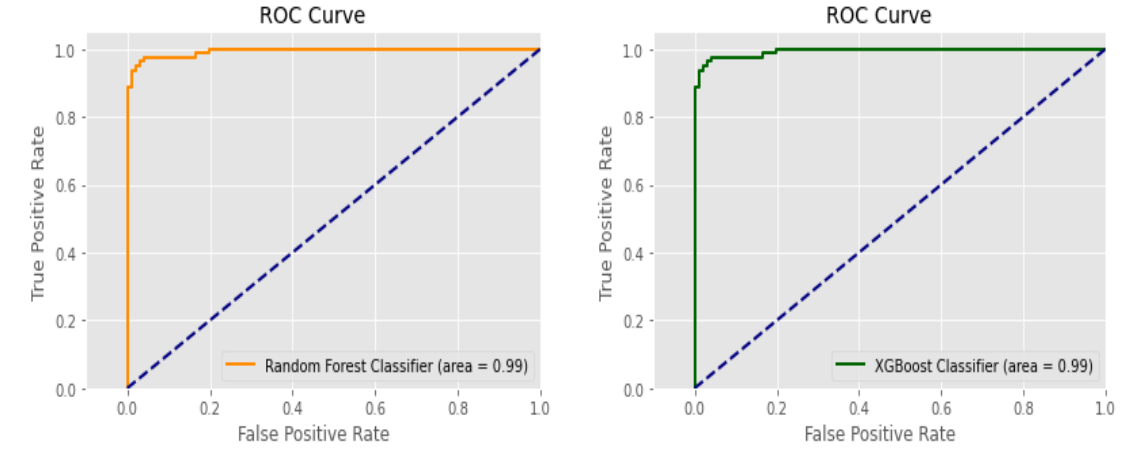
Figure 16. ROC curves for the RF and XGBoost classifiers.